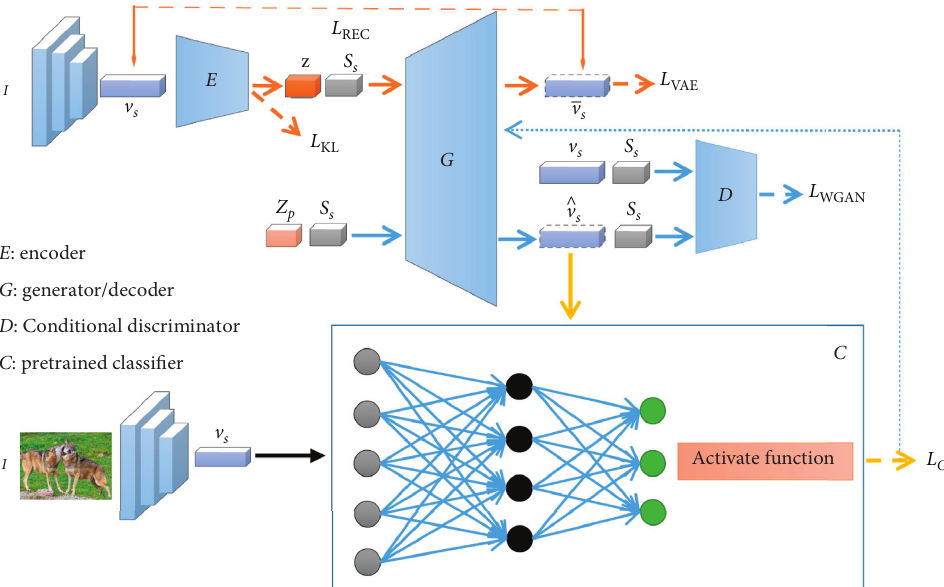
Figure 4: An overview of our proposed architecture, in which the upper part is a dual generation framework and the lower part is an additional classifier using discriminative information. Given the image samples I selected from seen classes, visual features v s are extracted from the Resnet101 which is pretrained on ImageNet1K and input to the netE (encoder), along with the corresponding semantic em- beddings s s . The latent noise vector z output from netE is then input together with semantic embeddings s s to the netG (generator) that synthesizes fake visual features v s . The netD (conditional discriminator) learns to distinguish real features v s from synthesized 􏽥 v s . Both netE and netG together constitute the so-called conditional VAE, which is training by L KL (KL divergence) and L (binary cross-entropy loss). BCE . The additional classifier is a multilayer fully-connected neural network, and we also Similarly, both netG and netD are trained using L WGAN discuss the influence of different classifier structures in the following.